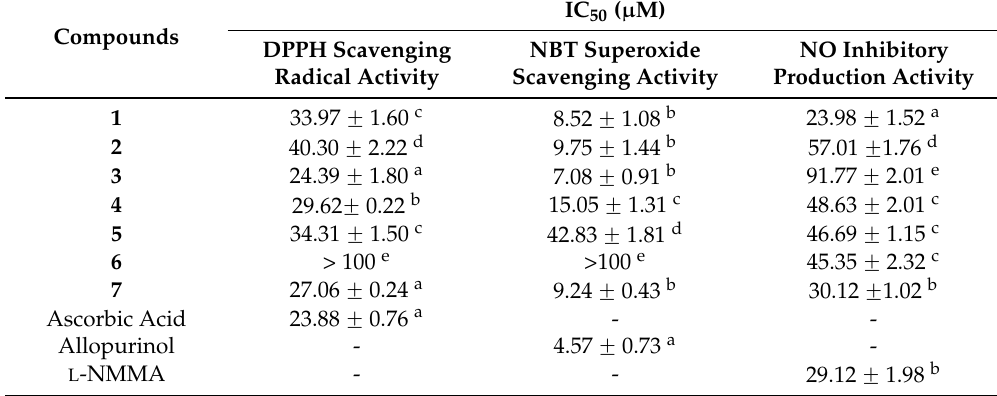
Table 1. IC 50 values of anti-oxidative and anti-inflammatory activities of compounds from AR.